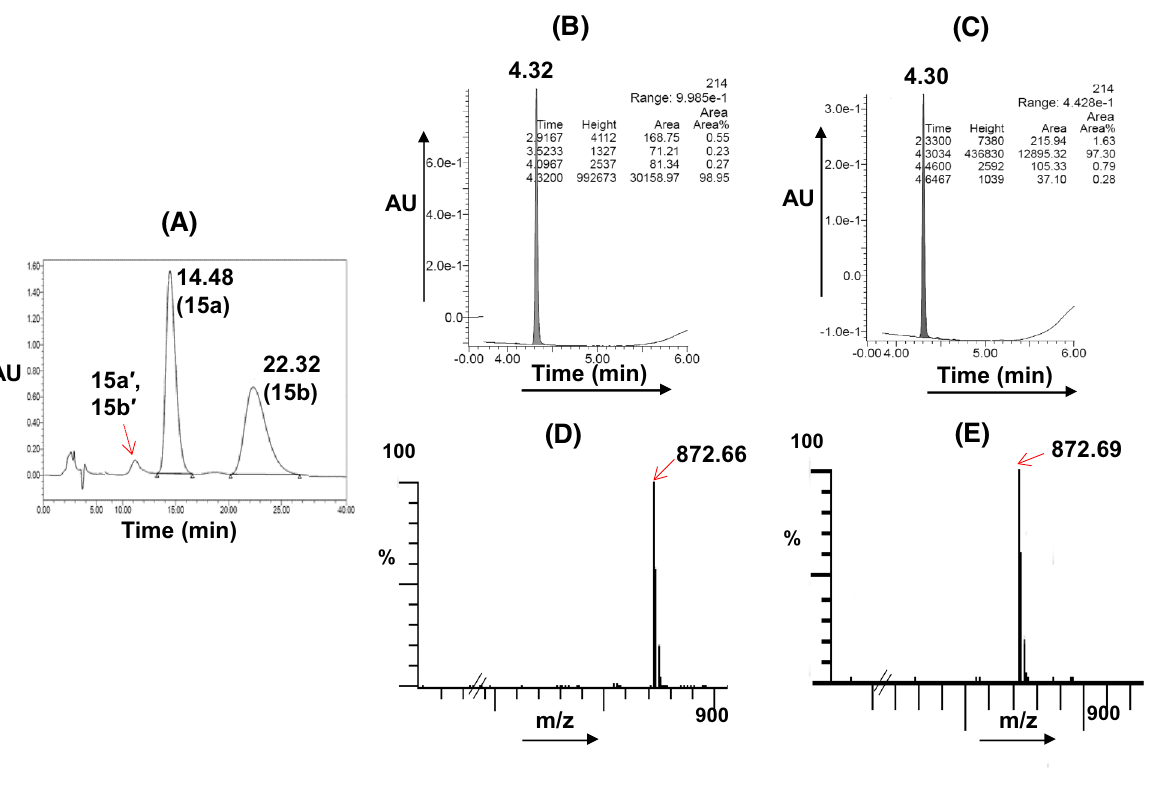
Figure 5. HPLC ( A ) chromatogram of original mixture of isomers of IVM-PQ 15 . UPLC chromatograms of individual isomers ( B : 15a ; C : 15b ). UPLC-MS chromatograms: ( D ): 15a and ( E ): 15b